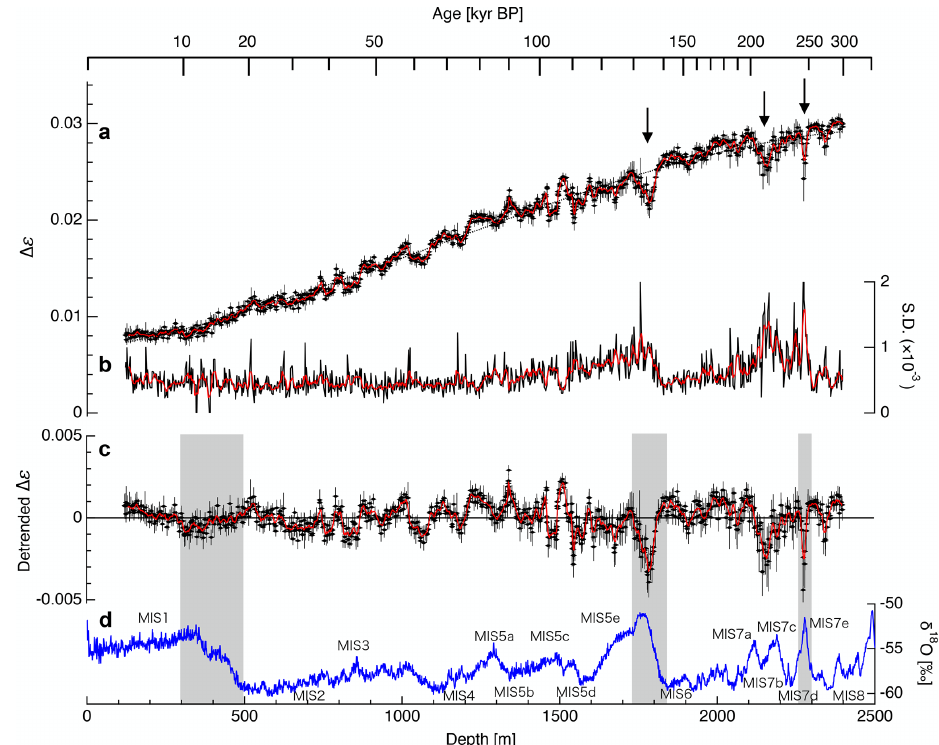
Figure 4. (a) Variations in (cid:49)ε along the DF1 ice core depth, showing the mean values for each core section (approximately 0.5m in length). Error bars correspond to the standard deviation (SD) within each core while the dotted line indicates a third-order fitting and the three arrows indicate depths associated with significant decreases. (b) The depth profile of the SD values for (cid:49)ε . (c) Detrended (cid:49)ε values, defined as deviations from the third-order fitting to the data in panel (a) . The red lines in plots (a) – (c) were generated by smoothing at 10m intervals. (d) Oxygen isotope ratios ( δ 18 O) in the DF1 ice core (modified from Dome Fuji Ice Core Members, 2017). The gray bands indicate the transition periods from glacial to interglacial. Marine Isotope Stage (MIS) events are also